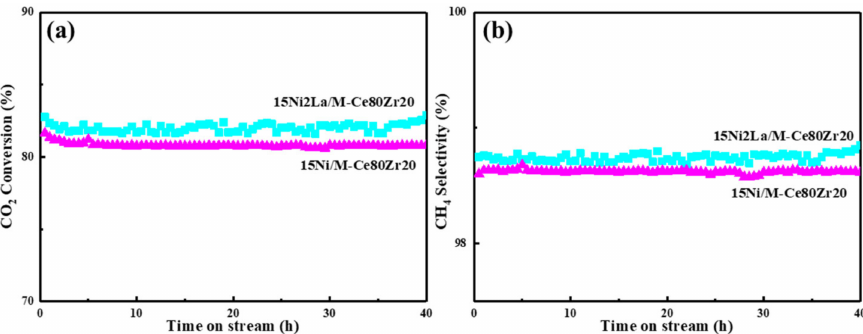
Figure 10. Forty hour long-term stability tests over the 15Ni/M-Ce80Zr20 and 15Ni2La/M- Ce80Zr20 catalysts: ( a ) CO 2 conversion, ( b ) CH 4 selectivity; reaction conditions: H 2 /CO 2 = 4, GHSV = 12,000 mL/(g · h), 400 ◦ C, 1 atm.